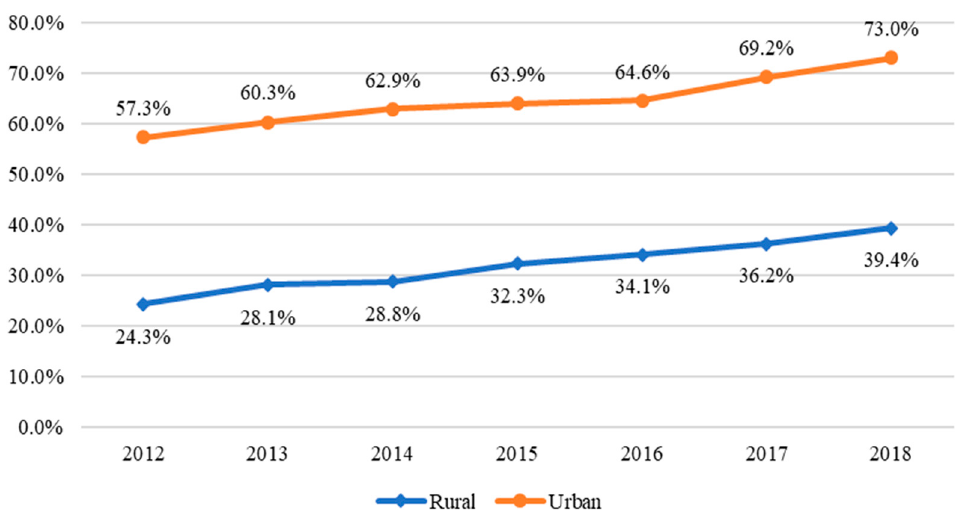
Figure 2. Proportion of netizens in China. Source: The Survey Report of 2012–2014 on China’s Rural Internet Development and report numbers 34–44 of the China Statistical Report on Internet Development issued by the CNNIC, and the National Bureau of Statistics of China (NBSC).